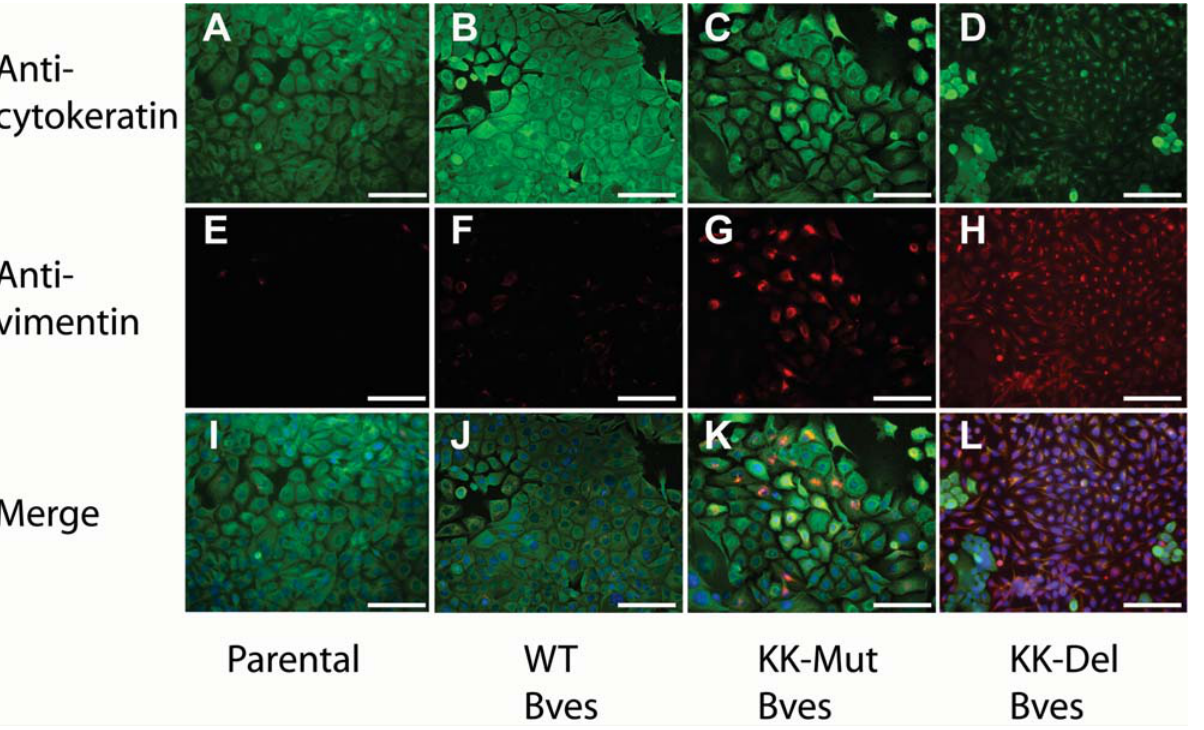
Figure 9. Immunostaining with anti-cytokeratin and anti-vimentin. Immunostaining with anti-cytokeratin (panels A through D), anti- vimentin (panels E through H) and merge (panels I through L) are given. A, E, I, Parental cells show high levels of cytokeratin and little vimentin staining. Transfection with WT Bves (B, F, J) shows similar staining patterns as parental cells. In contrast, cell lines expressing KK-Mut Bves (C, G, K) have a subpopulation of vimentin-positive cells and KK-Del Bves expressing cells (D, H, L) show nearly complete conversion to a vimentin-positive phenotype. (Scale Bar 100 m m)